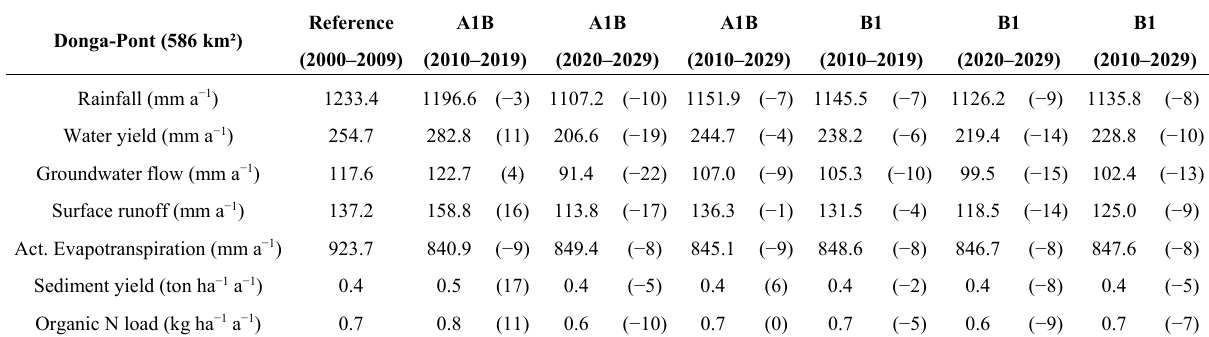
Table 7. Simulated SWAT components under climate scenarios (with unchanged land use map derived from 2003 Landsat image). Deviation (in %) from the reference scenario (2000–2009) are shown in